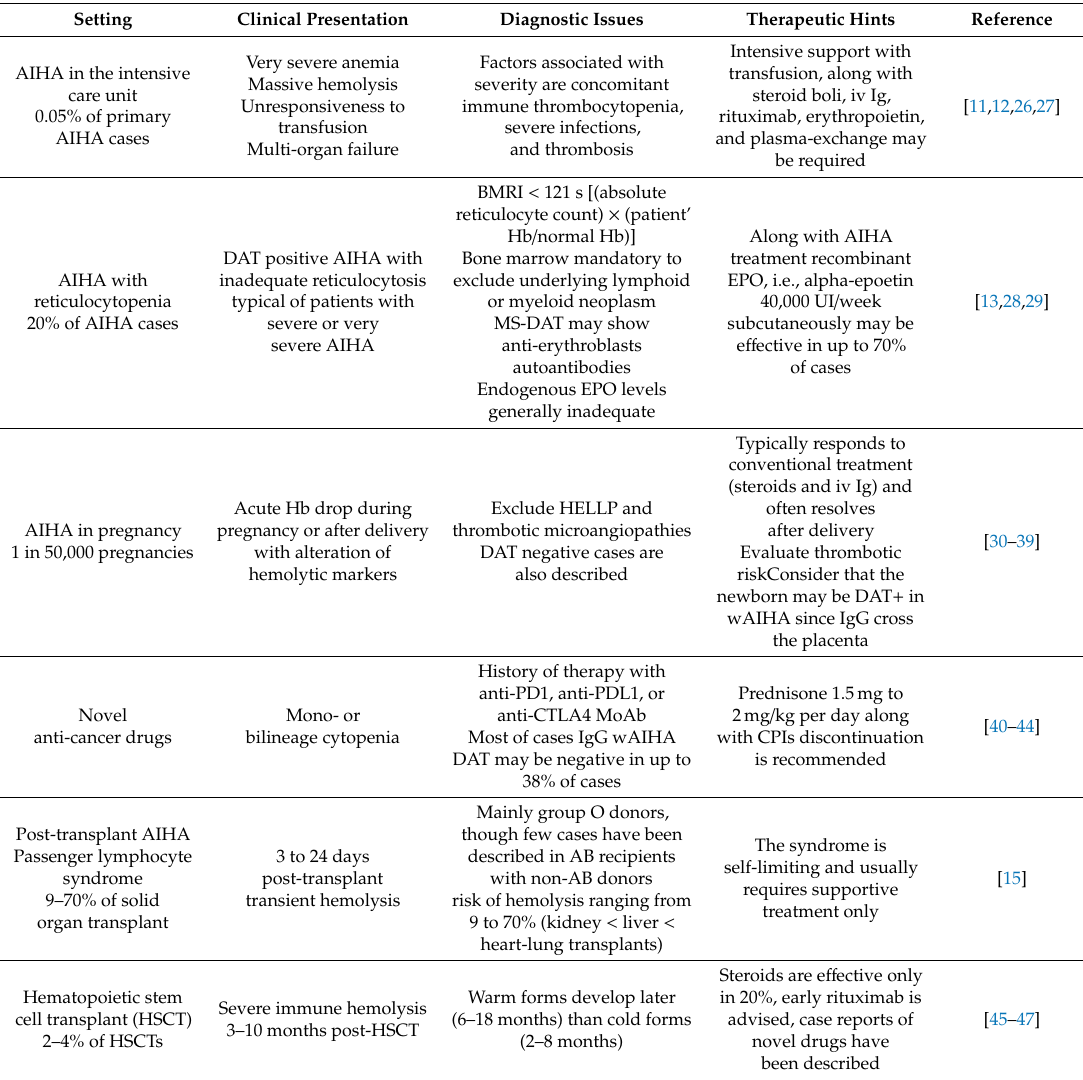
Table 2. Autoimmune hemolytic anemia (AIHA) in peculiar clinical